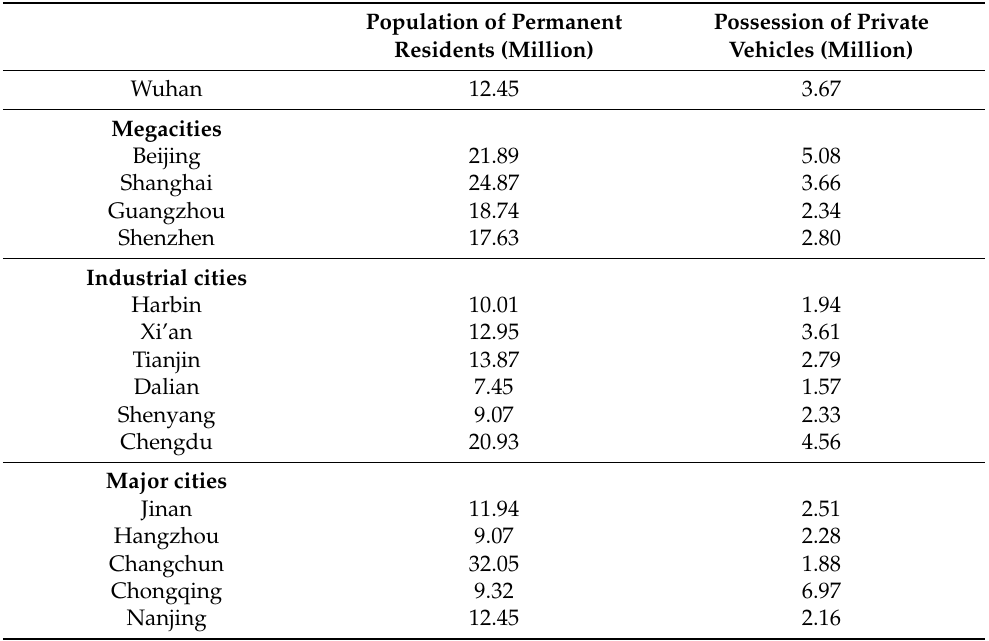
Figure 1. Locations of the 16 selected cities. Table 1. Population and car ownership of the 16 selected cities.